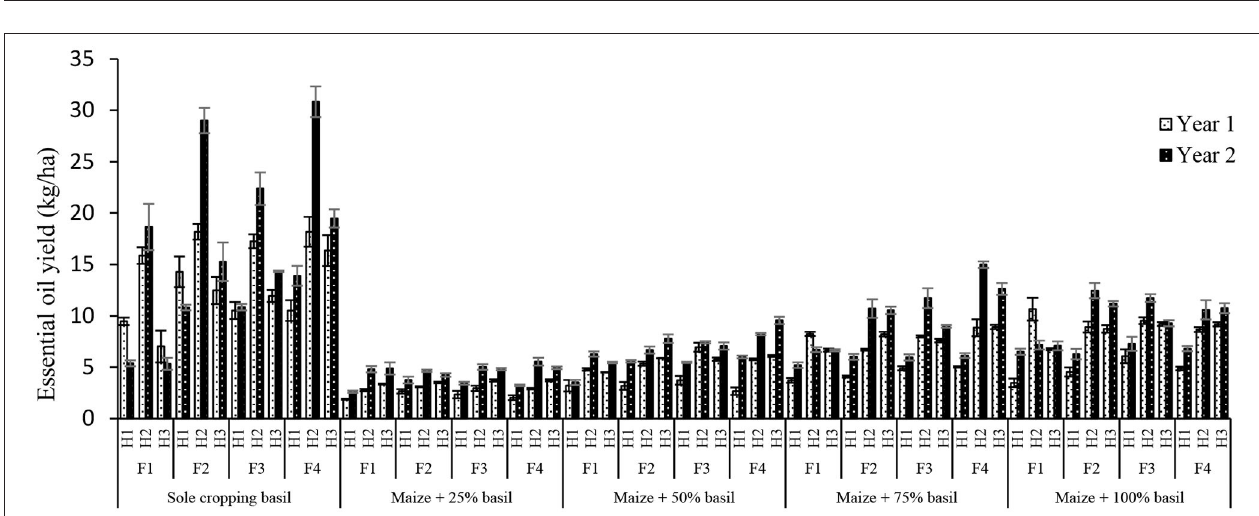
FIGURE 3 | Mean comparisons of interaction of different harvest and years of experiments on content of basil essential oil.